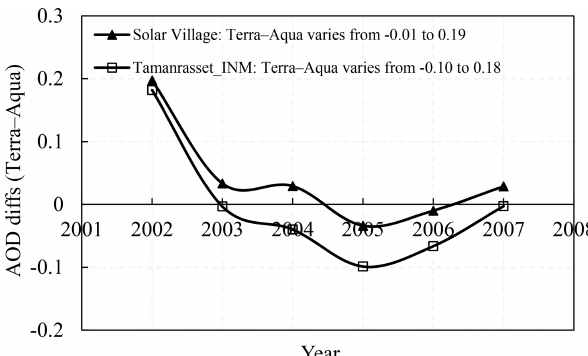
Figure 5. Long-term AOD difference for MODIS/Terra and MODIS/Aqua over the Solar Village and Taman